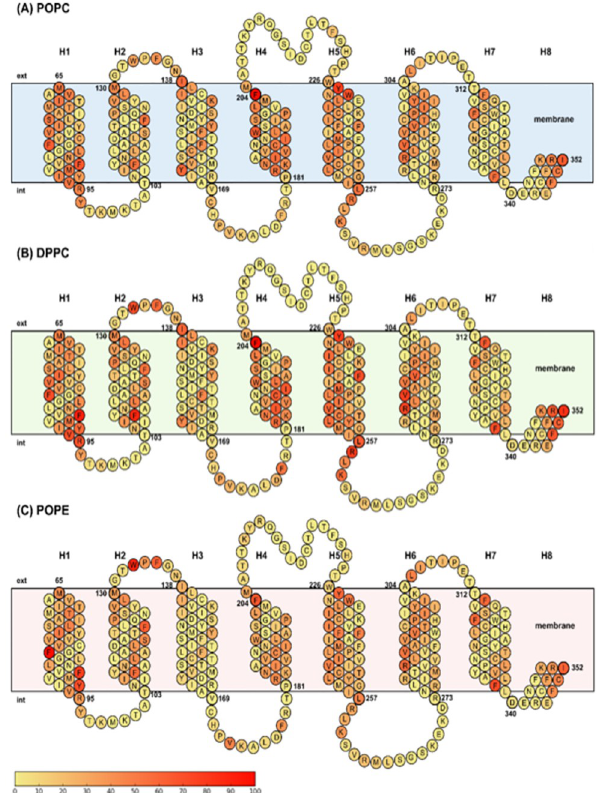
Fig 4. Primary structure of μ OR in (A) POPC, (B) DPPC, and (C) POPE membrane. Each AA of μ OR is colored as a function of its contact frequency with the lipids, as obtained from the 15 μ s CG MD runs at P = 1.01325 bar and T = 310 K, ranging from yellow (0%) to red